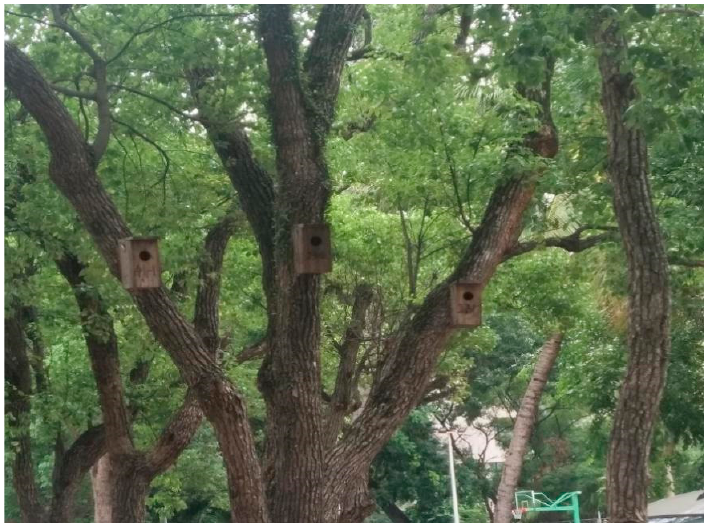
Figure 3. Three nest boxes were suspended on tree trunks in one nest box sample site. Cup nests weaved from hay and two captive-bred white-rumped munia ( Lonchura striata ) eggs (1.01 ± 0.15 g in egg mass, 15.20 ± 0.64 mm in egg length, 11.93 ± 0.68 mm in egg width; n = 20) were placed in all nest boxes, as shown in Figure 4. All munia eggs used in the experiment were all unfertilized eggs and were purchased online (Taobao Inc., Hangzhou, China). A total of 180 nest boxes were suspended, with each of 60 boxes at HNU, DLS, and QCF. The snake sloughs used in the experiment (Chinese cobra, Naja atra ) were obtained from crested myna’s nests in a local farm [12]. Figure 4. Eggs of the white-rumped munia ( Lonchura striata ) used in this study. Three nest boxes of a nest box sample site were randomly placed separately in DLS and QCF: a brownish gray cloth (10 cm) was added to the nest boxes (the experimental group EC), 10 cm of snake sloughs was added to the nest boxes (the experimental group E), and no treatment was applied to the nest boxes (the control group C). Three treatments were randomly placed correspondingly in three nest boxes of a nest box sample site in HNU: 10 cm of snake slough was added to the nest boxes (the experimental group E), 10 cm of snake sloughs was suspended at the mouth of the nest boxes (the experimental group ES), and no treatment was applied to the nest boxes (the control group C). As the